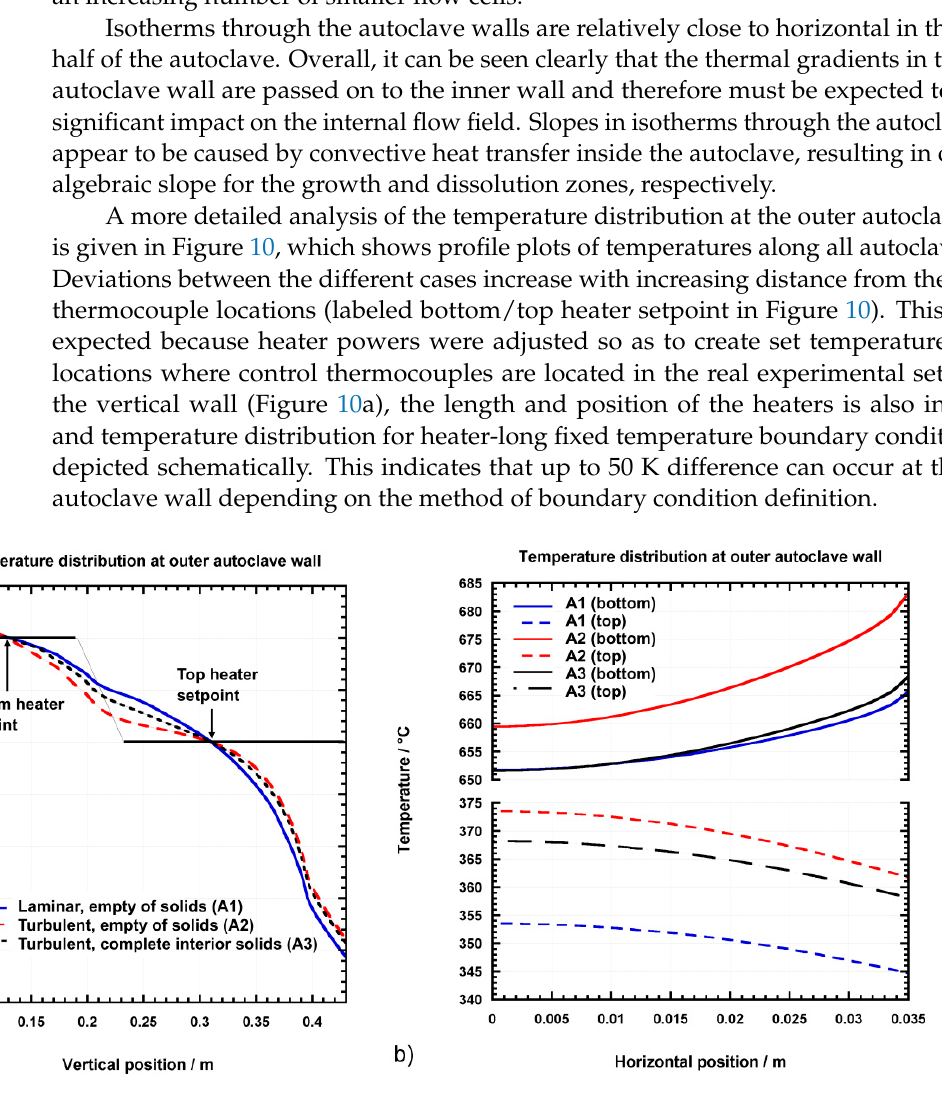
Figure 10. Temperature distributions at outer autoclave walls determined by simulations of the complete setup including the furnace. ( a ) Vertical autoclave wall. ( b ) Horizontal autoclave walls (horizontal position of 0 corresponds to symmetry axis of autoclave). For the top autoclave wall, a position in the autoclave head corresponding to the thickness of the bottom autoclave wall was chosen, as this mimics a suitable choice for simulations that do not include the furnace.